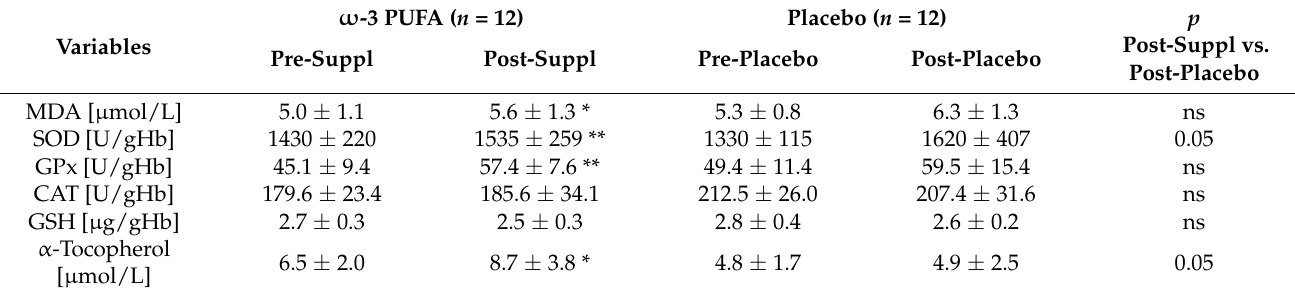
Table 6. Oxidative status in the supplemented group ( ω -3 PUFA) and placebo group (Placebo) (mean, SD).